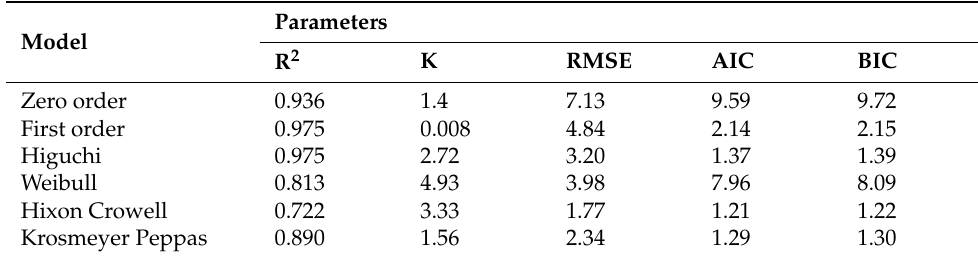
Table 6. Release kinetics of optimized formulation.